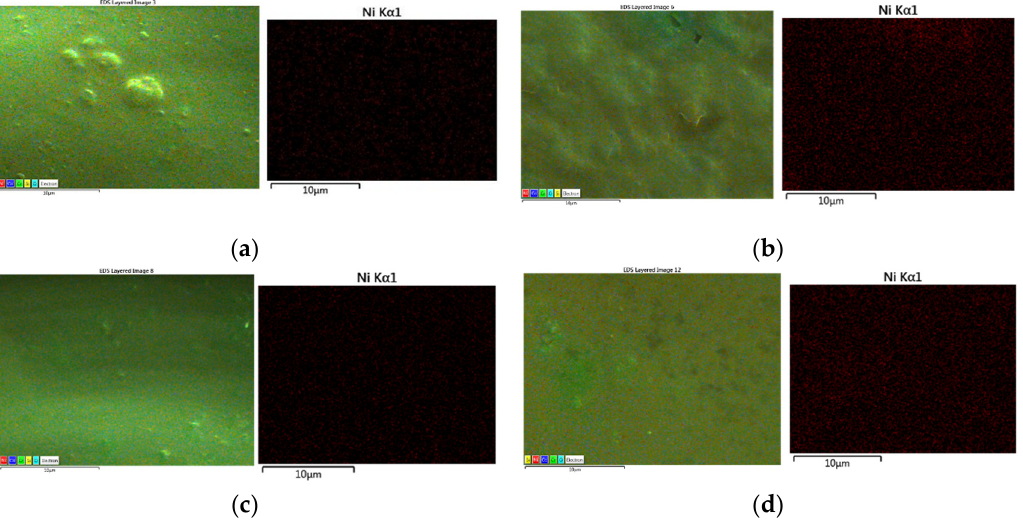
Figure 10. EDX element layered image including Ni K α 1 of the ceramic glossy tile cross-section as a function of nickel substitution in the chromite spinel (Co (1 − x) Ni x Cr 2 O 4 ) where ( a ) x = 0.25, ( b ) x = 0.5, ( c ) x = 0.75 and ( d ) x = 1.